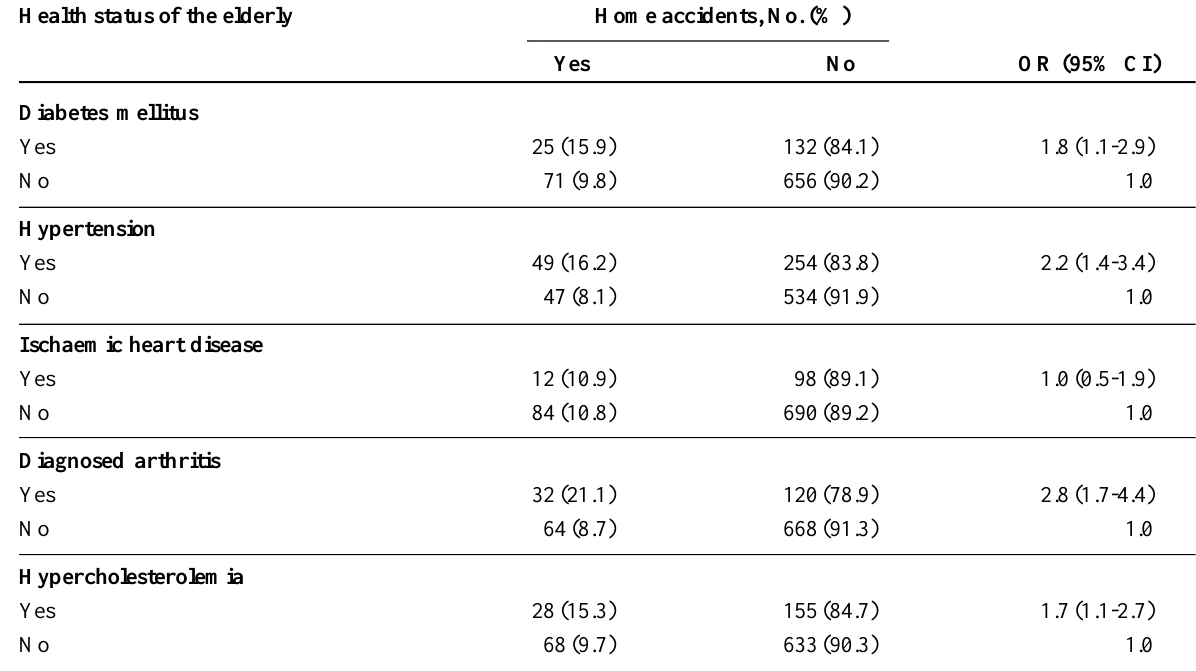
Table 3. Health status of the elderly and the occurrence of home accidents Health status of the